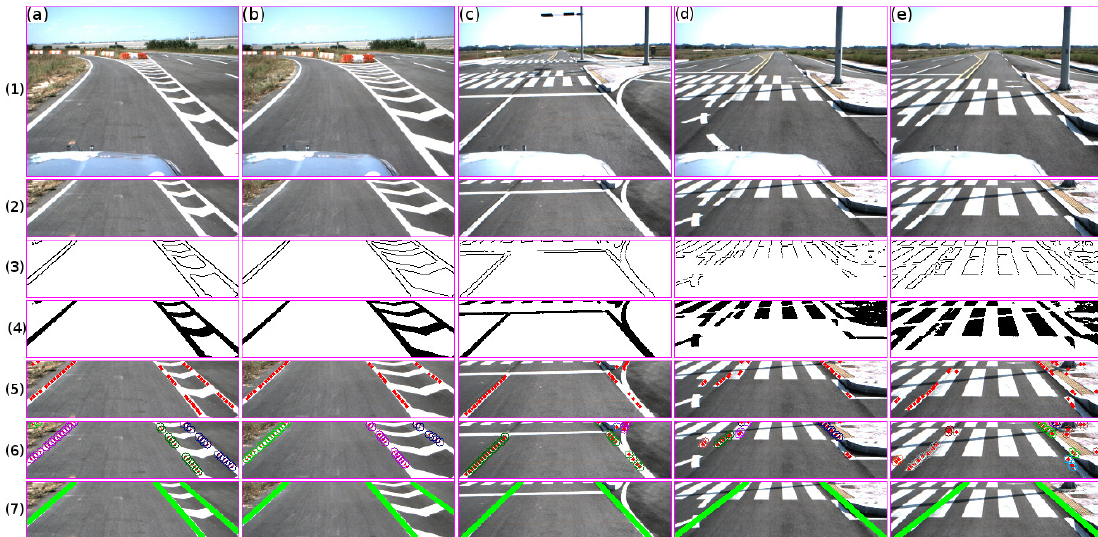
Figure 9. Lane marking results in regions that contain different markers such as white channelizing lines ( a , b ), stop lines ( c ), and crosswalk pavement markers ( d , e ). The rows show the results at each step. The first row shows the input image. The second row shows the road region of interest. The third and fourth rows show the binary image for both the edge and color probability method. The fifth row shows the extracted set of midpoints for each frame. The sixth row shows the result of the clustering process. The seventh row shows the line/curve fitting result.